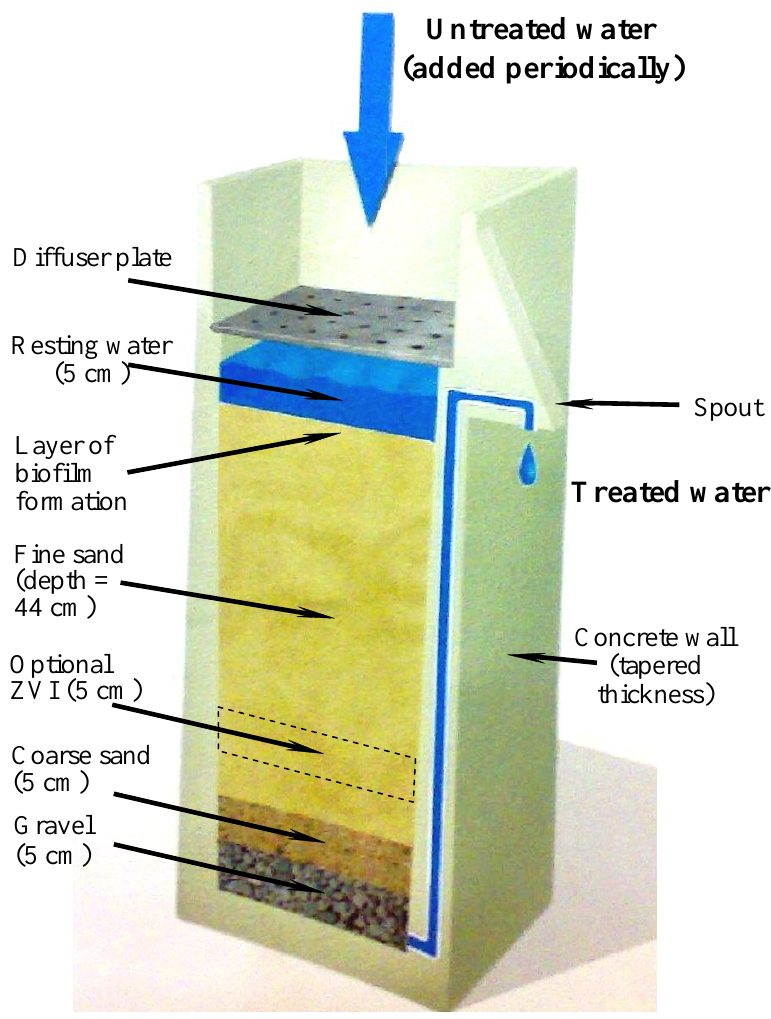
Figure 1. Cross-sectional diagram of a traditional concrete intermittent bio-sand filter (BSF). Such a filter was used in these experiments (Modified from CAWST [8]). The zero-valent iron (ZVI) layer is only included in filter